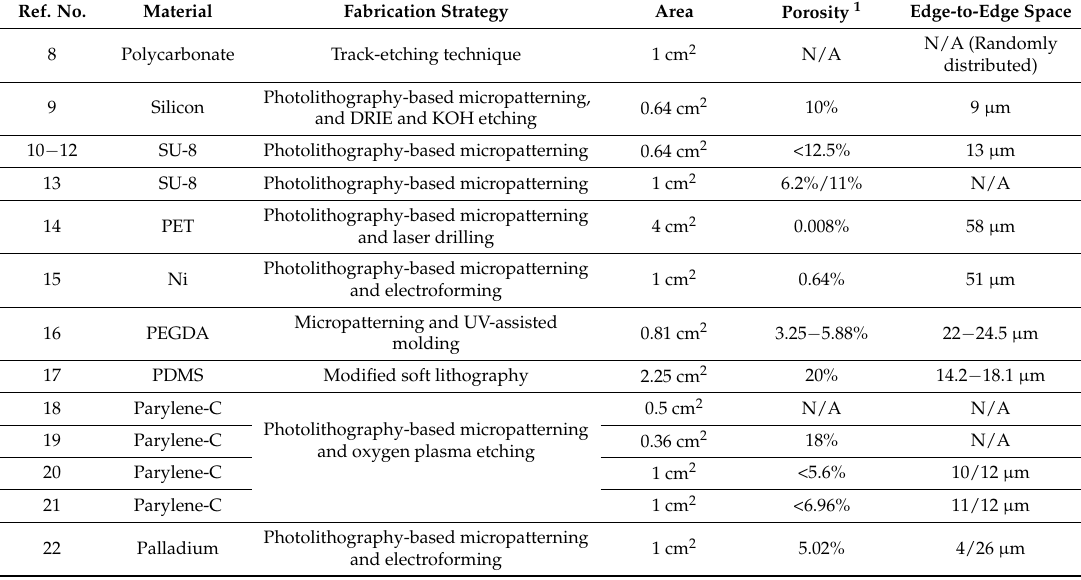
Table 1. Summary and comparison of the reported micropore